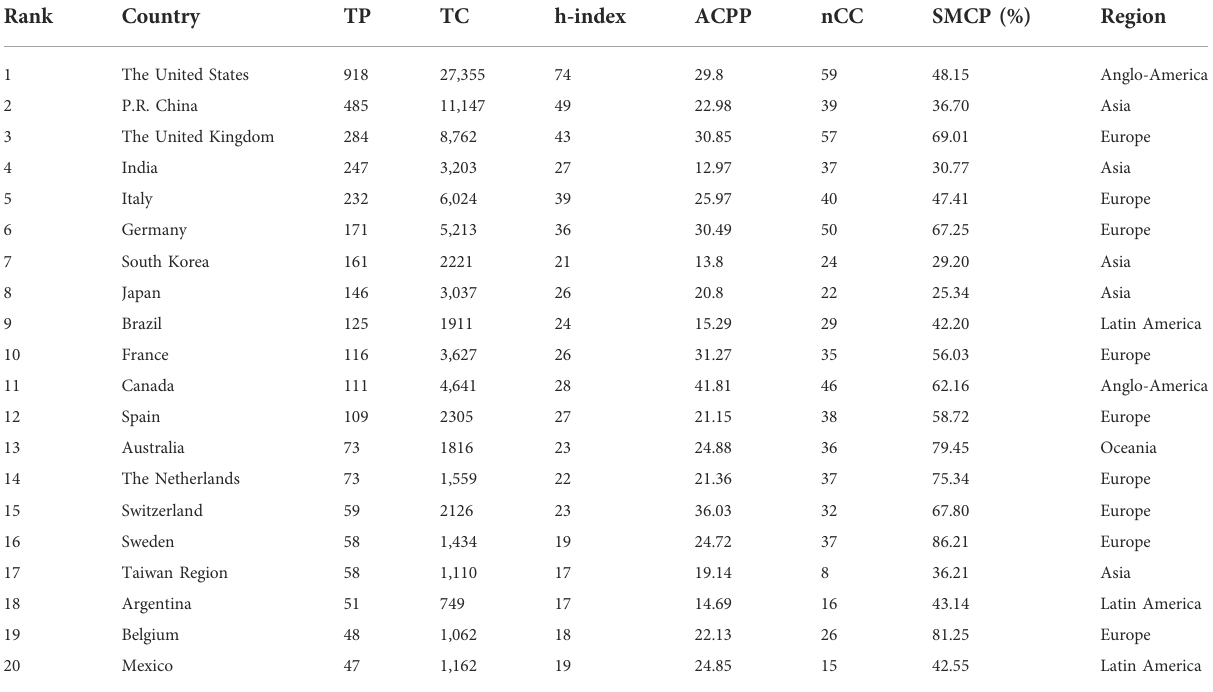
TABLE 1 Top 20 most productive countries/regions in the fi eld of drug